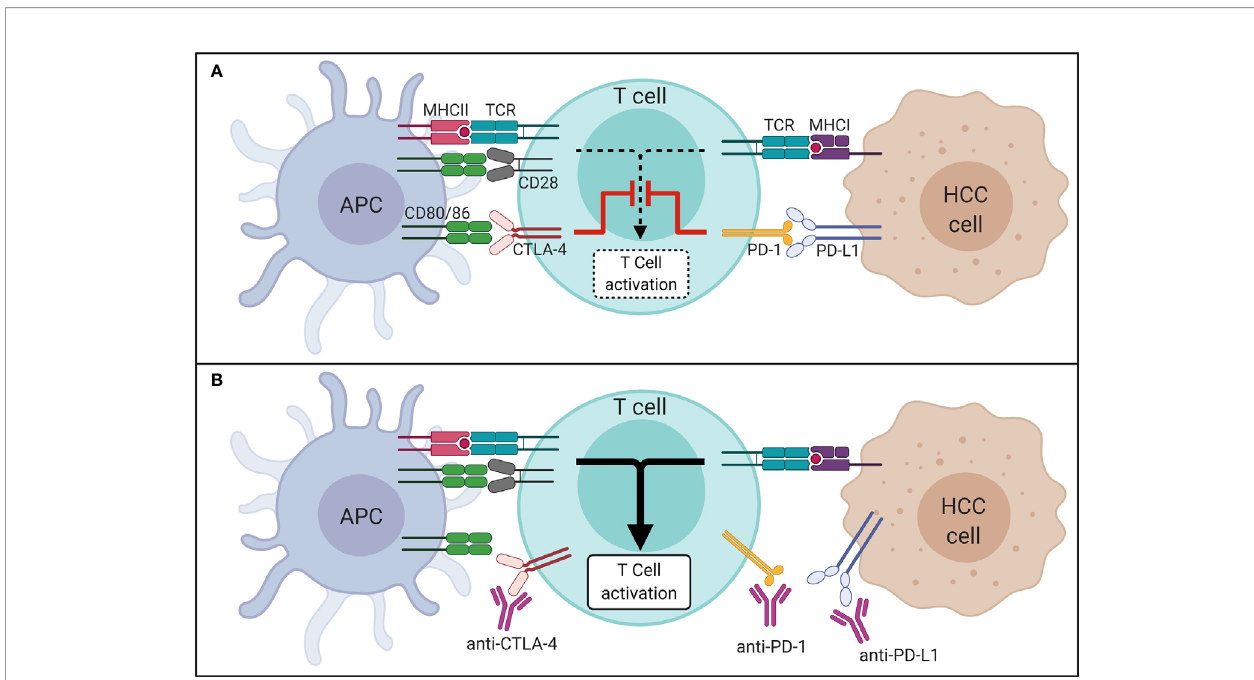
FIGURE 1 | Mechanism of immune checkpoints in HCC in absence (A) and presence (B) of ICI. APC, antigen presenting cell; CTLA-4, cytotoxic T-lymphocyte- associated protein 4; HCC, hepatocellular carcinoma; ICI, immune checkpoint inhibitor; MHC, major histocompatibility complex; PD-1, programmed cell death 1 protein; PD-L1, programmed death-ligand 1; TCR, T cell